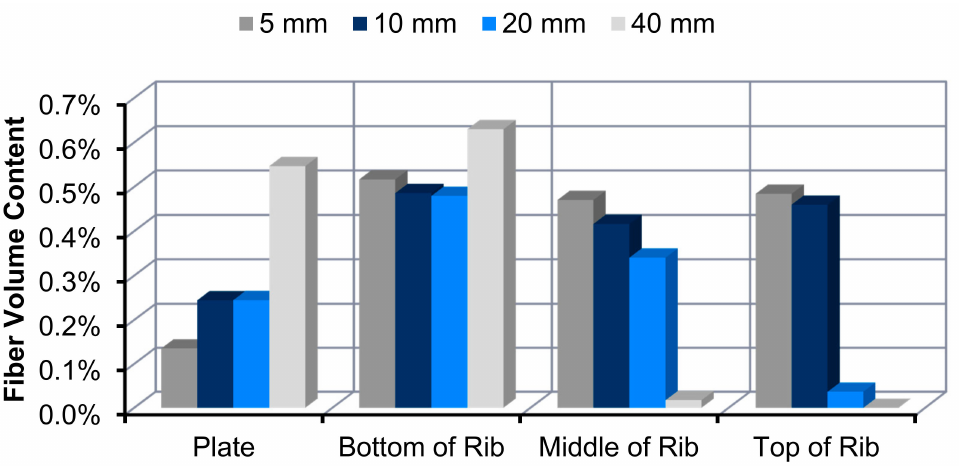
Figure 12. Fiber volume fraction throughout rib for different fiber lengths. All simulations used a center charge, random initial fiber orientation and a rib entrance radius of 7 mm.